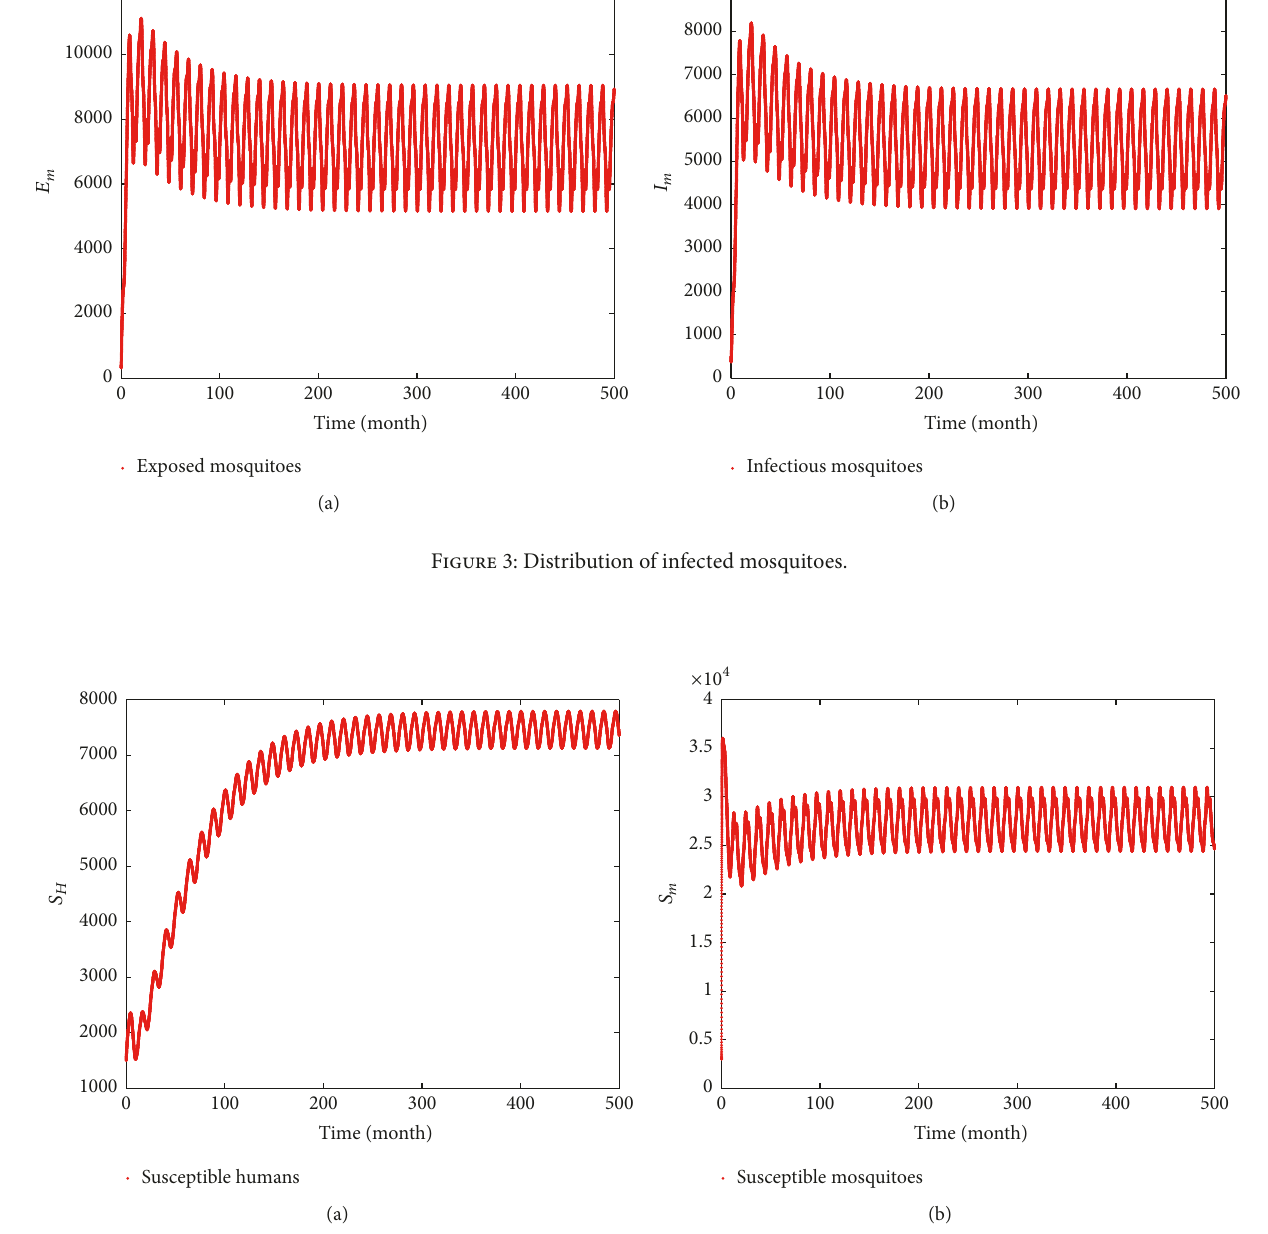
Figure 4: Distribution of susceptible humans and